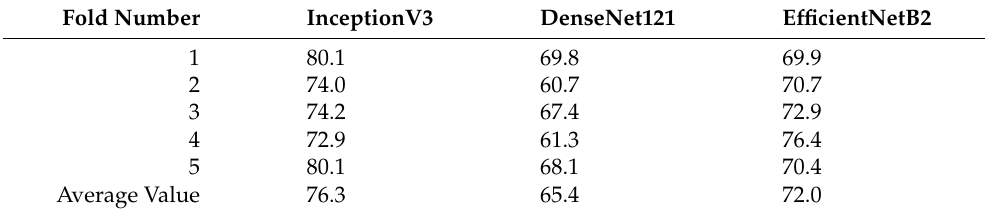
Table 11. Validation accuracy of single Chinese character multi-category classification of affrication class.